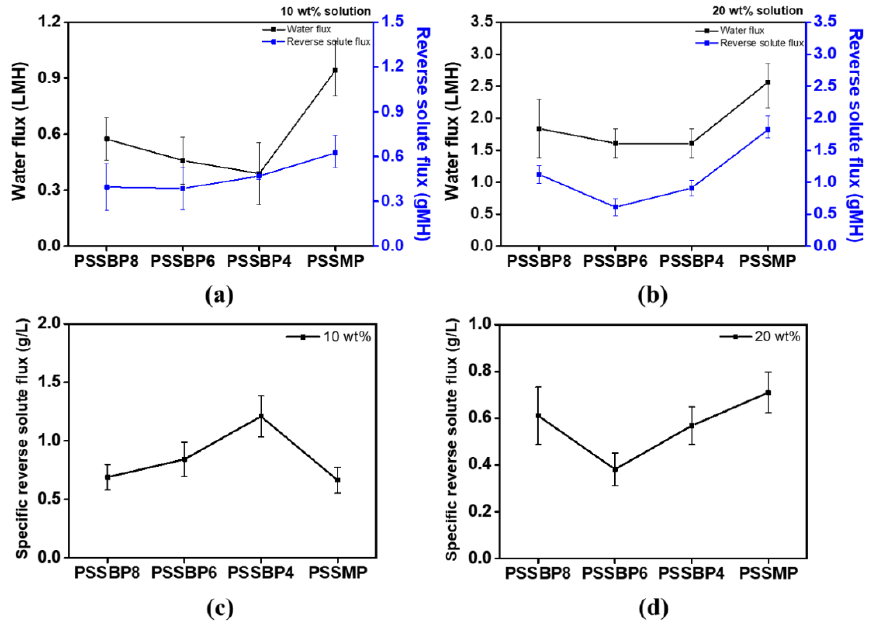
Figure 8. Water flux and reverse solute flux of PSSBP# series and PSSMP at solution concentration, ( a ) 10 wt% and ( b ) 20 wt% in room temperature in the FO process and specific reverse solute flux of the draw solutes at ( c ) 10 wt% and ( d ) 20 wt%.